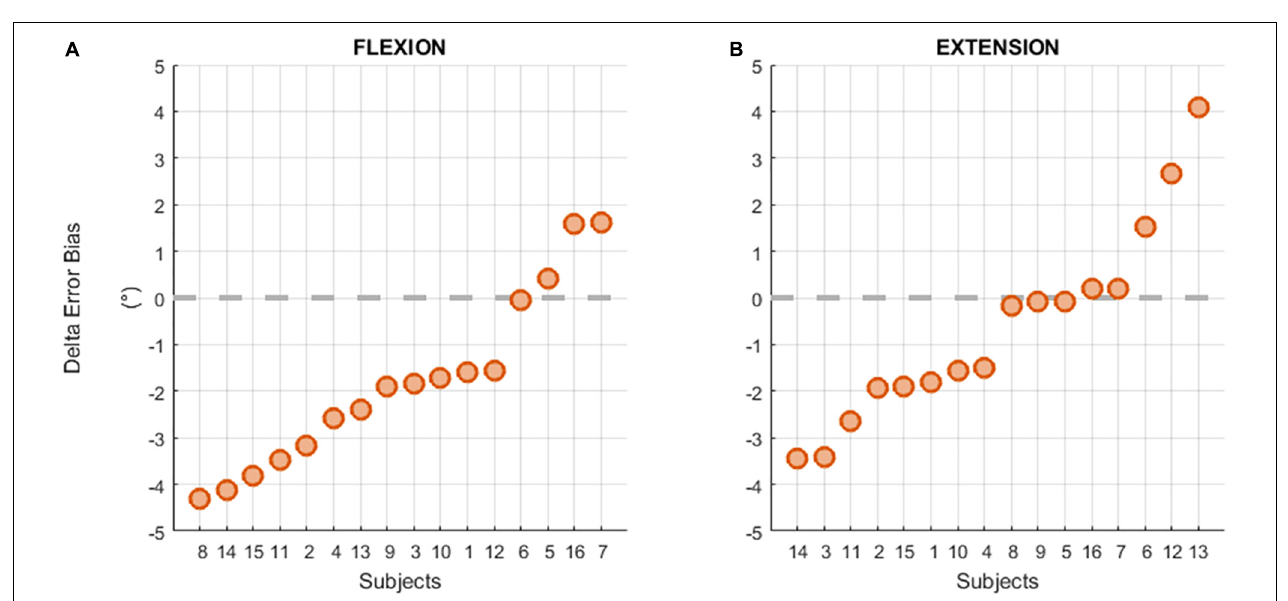
FIGURE 6 | Individual differences between the Error Bias before and after the fatigue task in flexion (A) and extension (B) movements.